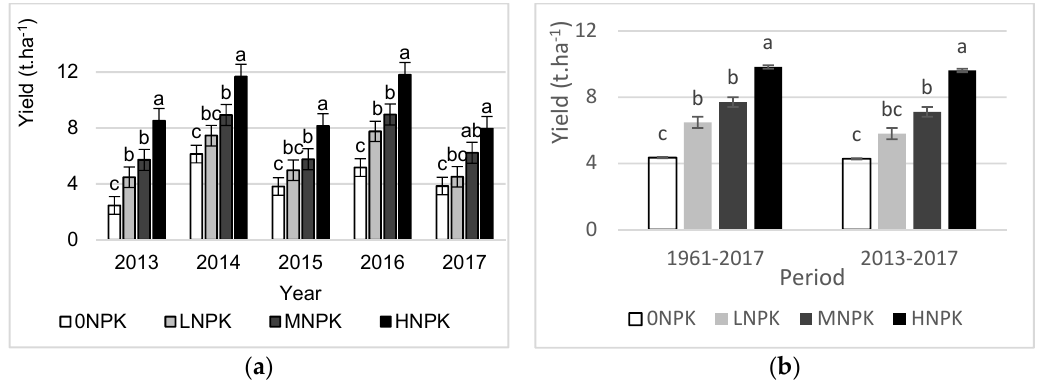
Figure 3. Plant biomass yield ( a ) mean values for 57-year period and period of last 5 years; ( b ) mean values for 2013, 2014, 2015, 2016, and 2017. Different letters indicate treatment differences at P < 0.01.